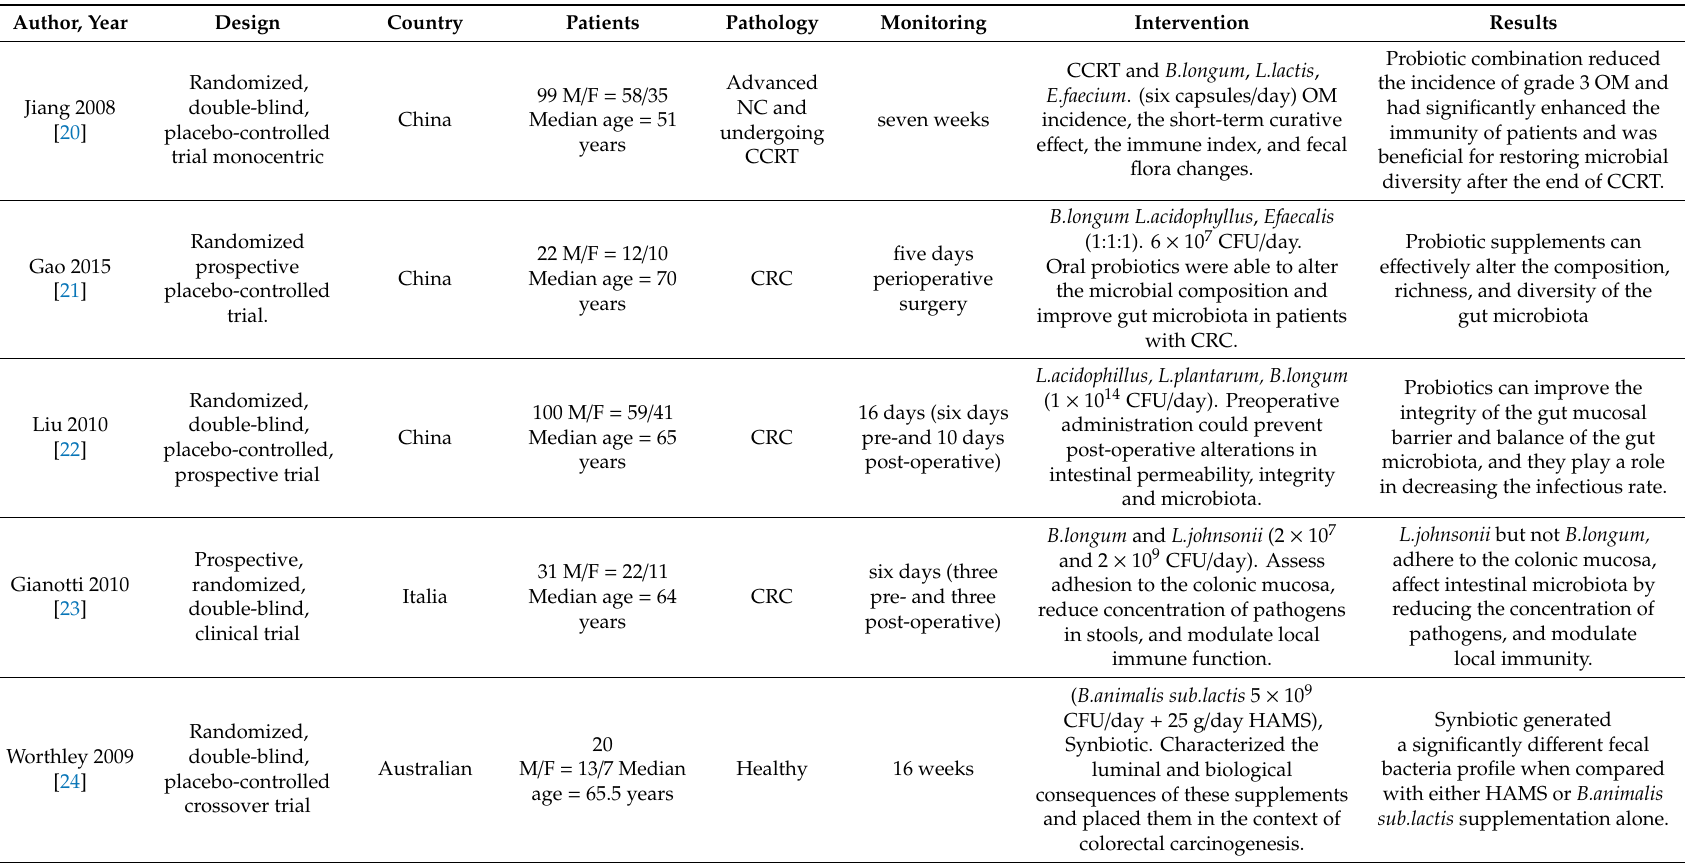
Table 2. Summary of reviewed studies on the relationship probiotics and mucositis in cancer